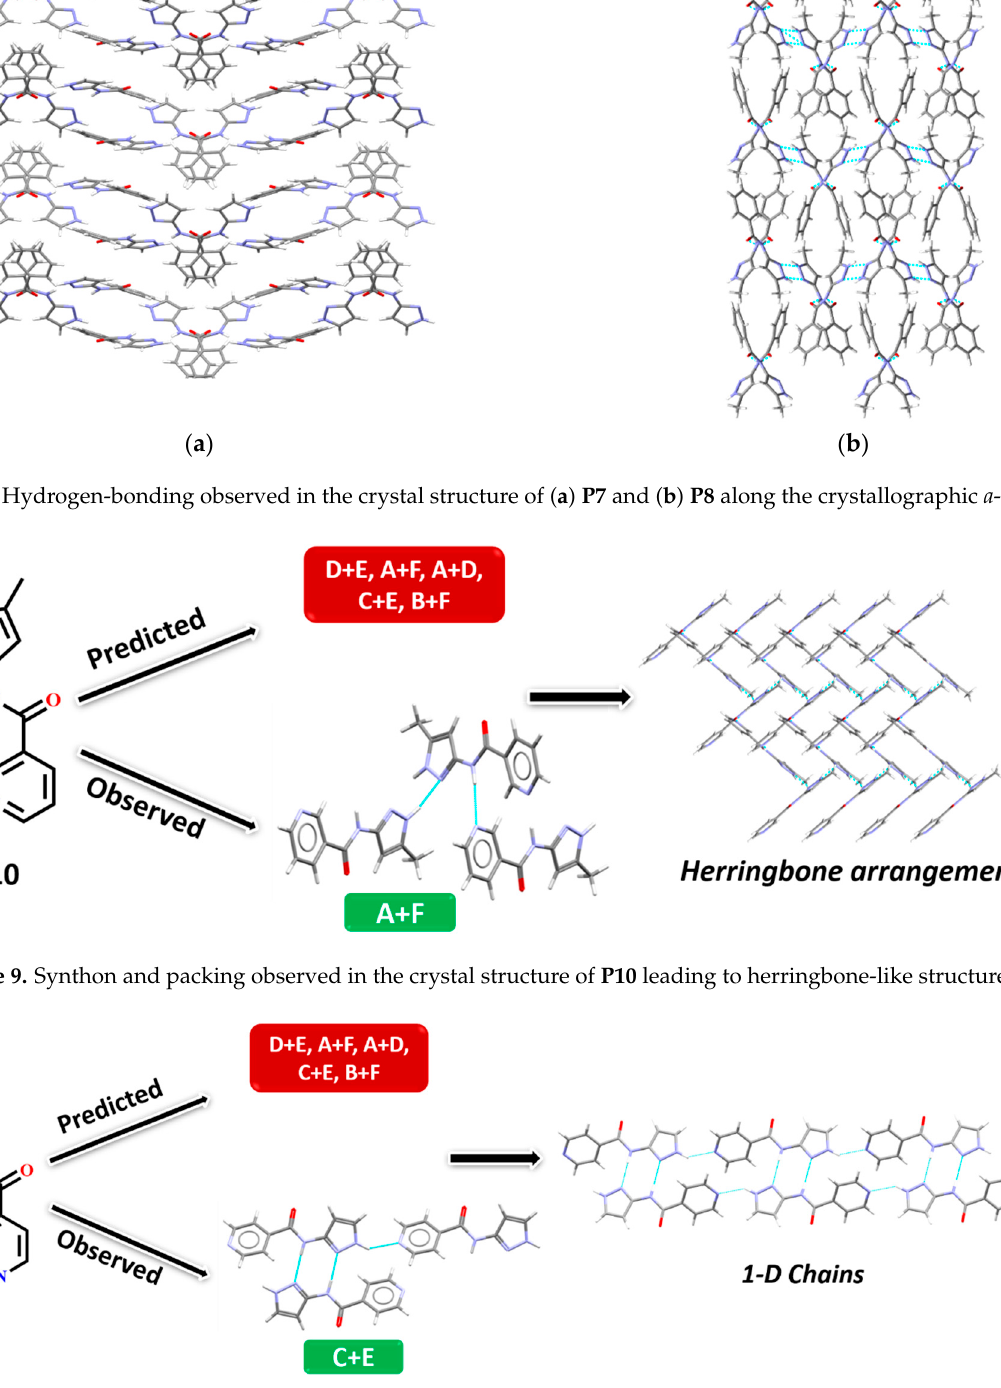
Figure 10. Synthon and packing observed in the crystal structure of P11 leading to 1-D chains along the crystallographic a -axis.